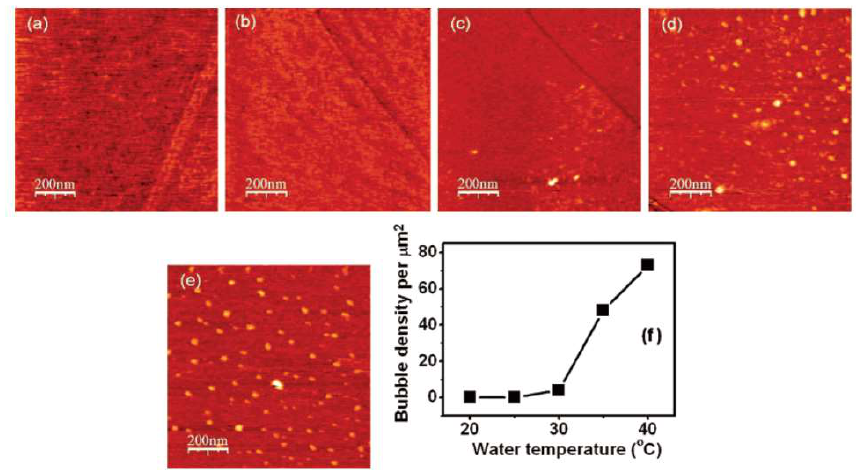
Figure 5. AFM images at different water temperatures in intervals of 5 °C:20–40 °C ( a – e ). ( f ) The NB density as a function of water temperature. Reprinted with permission from [22].